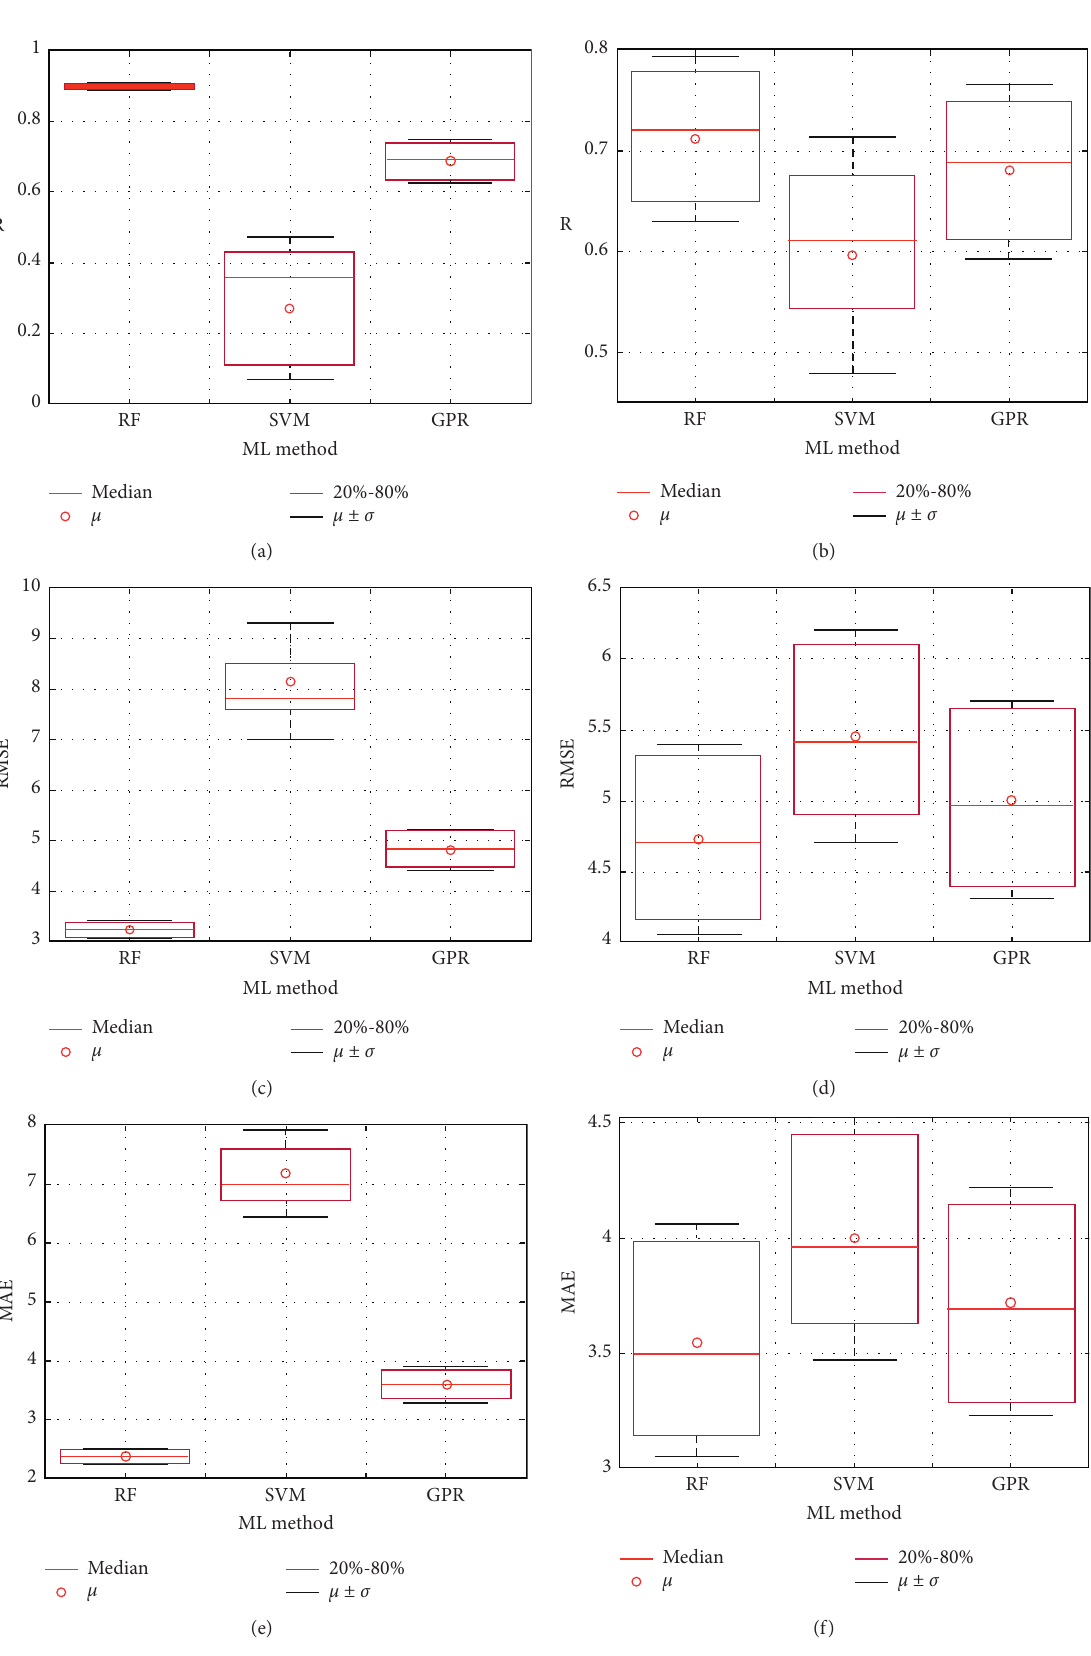
Figure 10: Box-plot of the prediction results over 200 simulations for the 3ML algorithms (a) R for the training dataset, (b) R for the testing dataset, (c) RMSE for the training dataset, (d) RMSE for the testing dataset, (e) MAE for the training dataset, and (f) RMSE for the training dataset. The symbol µ denotes the mean values, σ denotes the standard deviation, and the 20%–80% denotes the quantile level of the results, respectively, from 20% to